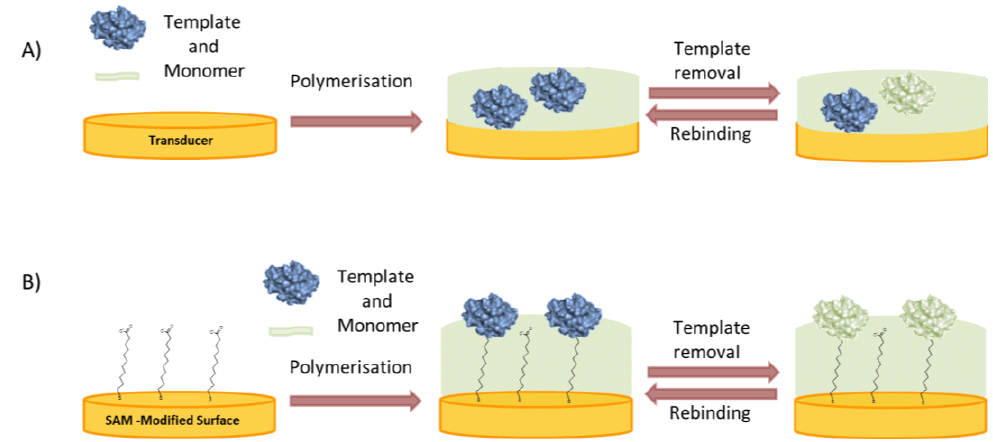
Figure 5. Surface imprinting approaches for the synthesis of MIP films for selective recognition of proteins: ( A ) Polymerization of a mixture of protein and monomer; ( B ) Binding of the protein to a self-assembled anchor layer for oriented immobilization of the protein prior to polymerization.